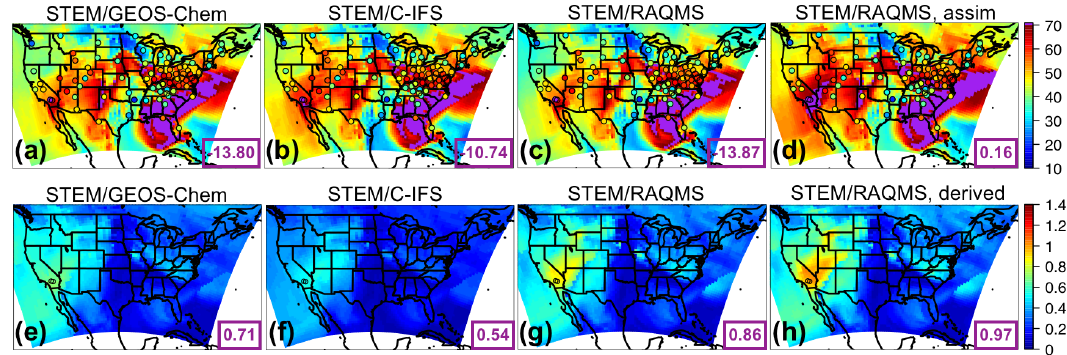
Figure 18. Same as Fig. 15, but for a case study of 10 June 2010. The CASTNET sites with O 3 exceedances on this day are Converse Station and Joshua Tree NP in southern